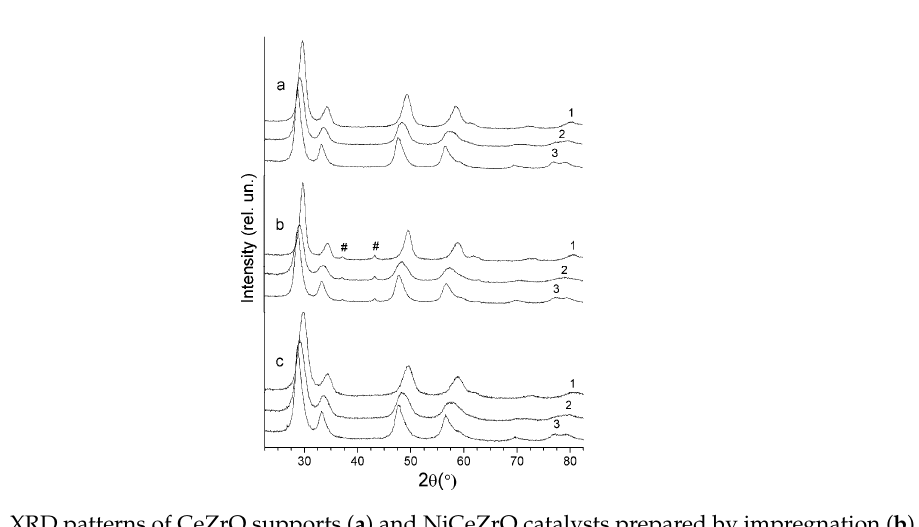
Figure 2. XRD patterns of CeZrO supports ( a ) and NiCeZrO catalysts prepared by impregnation ( b ) and one-pot method ( c ): 1—Ce 0.3 Zr 0.7 ; 2—Ce 0.5 Zr 0.5 ; 3—Ce 0.7 Zr 0.3 . #-reflections of NiO